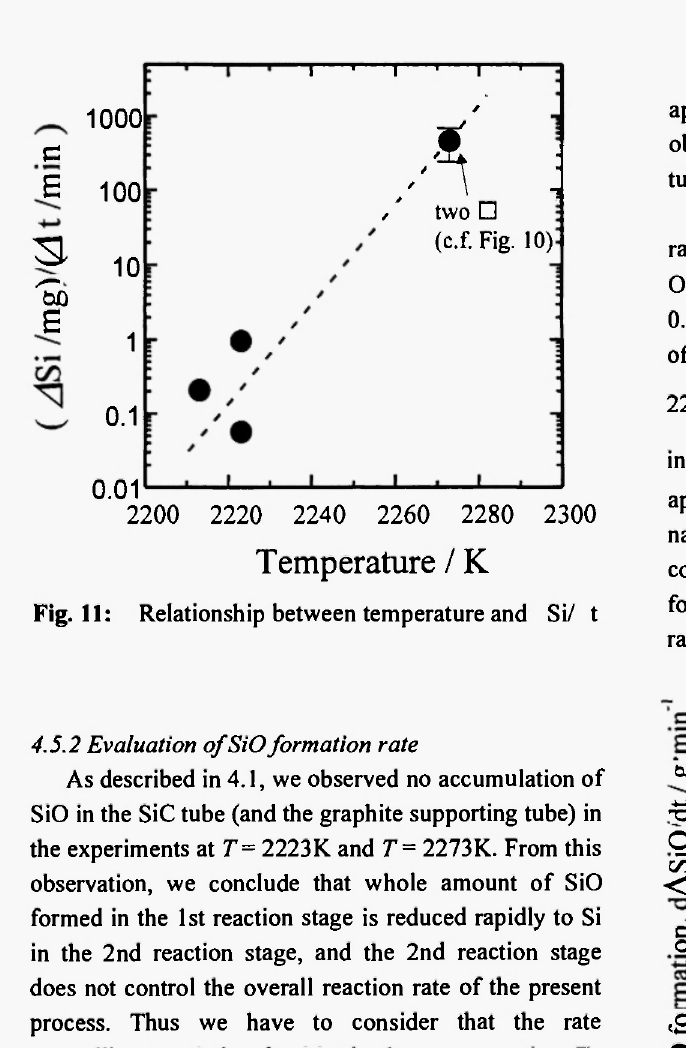
Relationship between d SiO/dt and